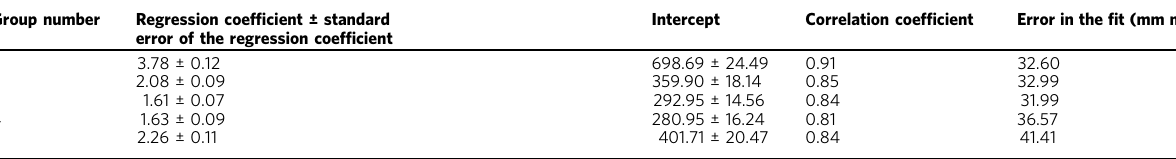
Table 2 The regression coef fi cient and standard error of the regression coef fi cient, intercept, correlation coef fi cient, and the RMS error the in fi t (mm month − 1 ) between ET-P simulations and ET-P estimates based on simulated δ D _004 for the same fi ve 5 groups of Table 1.